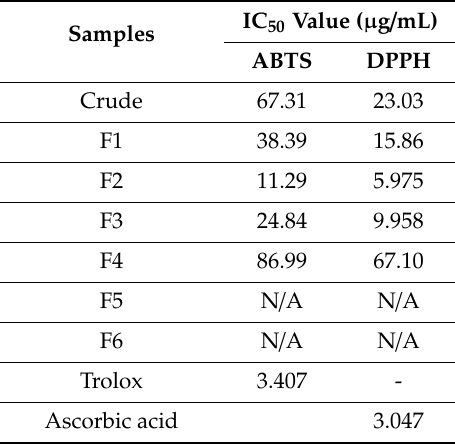
IC 50 values for 2,2 (cid:48) -Azino-bis(3-Ethylbenzothiazoline-6-sulphonic acid) (ABTS)